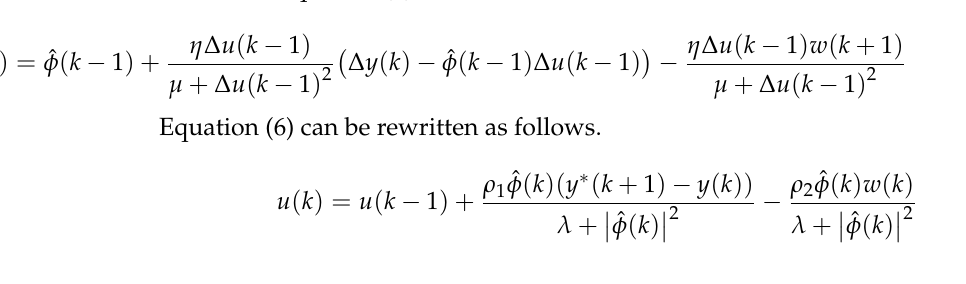
Figure 8. Topology Structure of RBFNN.